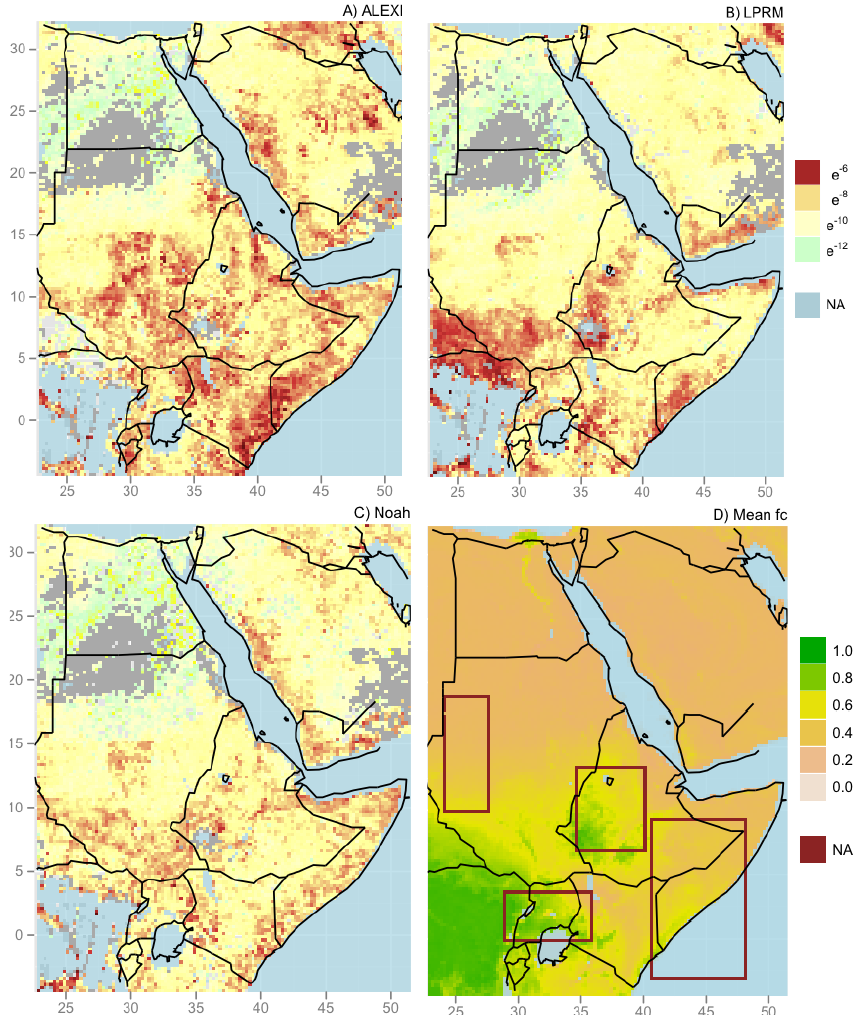
Fig. 7. The variance of the triple collocation analysis-based errors in (m 3 m − 3 ) 2 for each product juxtaposed with the annual average fraction of green vegetation cover. (A) ALEXI TCA, (B) LPRM TCA, (C) Noah TCA, (D) mean fraction of green vegetation cover over the period 2007 to 2011. Gray areas in panels (A) – (C) indicate regions below the correlation threshold for the TC analysis ( r < 0.2). Red boundaries in panel (D) indicate bounding boxes for the analysis in Tables